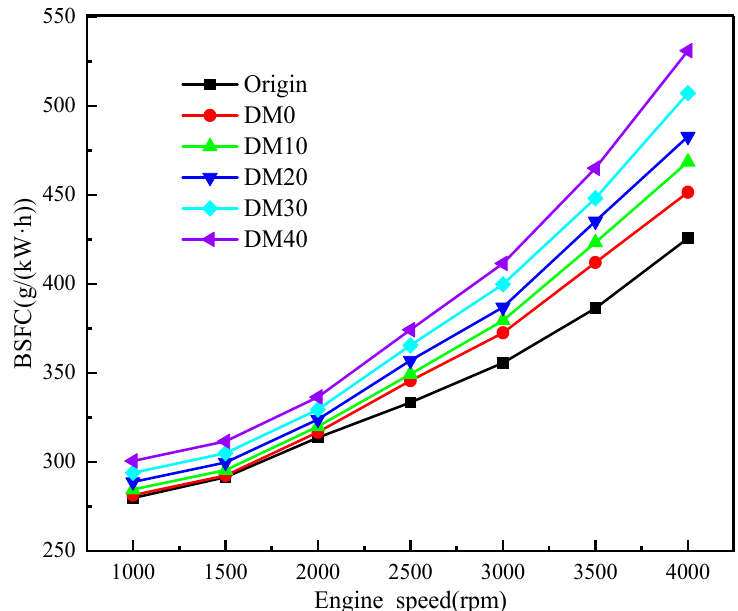
Figure 7. Effect of different ratios of methanol-diesel mixtures on BSFC at different speeds.